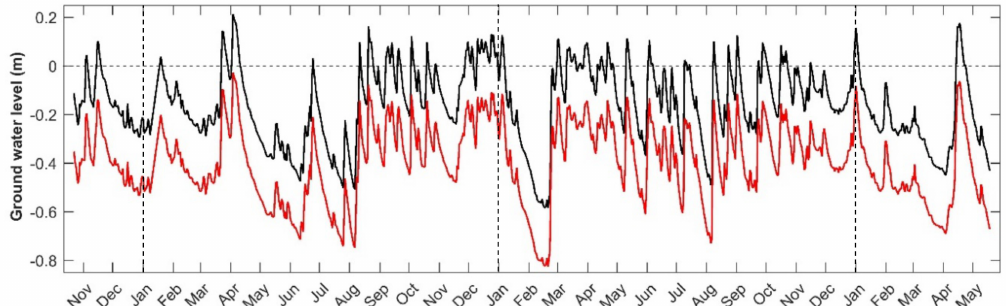
Figure 7. Daily average distance between the soil surface and the groundwater table at plot 1 (black line) and plot 2 (red line) from 22 October 2010 to 19 May 2013. Vertical dashed lines mark the start of a new